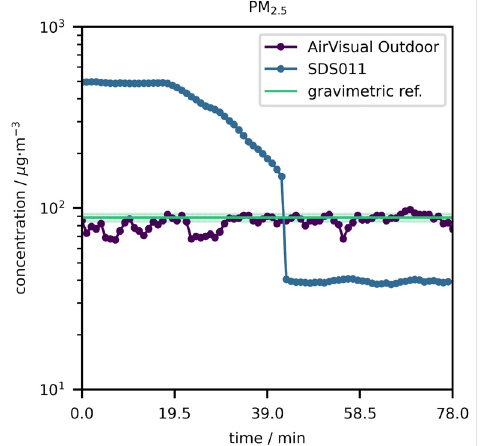
Figure 3. PM 2.5 mass concentrations reported by the AirVisual Outdoor and SDS011 as a function of time for model aerosol 2. The green line refers to the average mass concentration over the whole measurement period according to the gravimetric reference method, while the shaded green area designates the expanded uncertainty ( k = 2; 95% confidence interval) thereof.